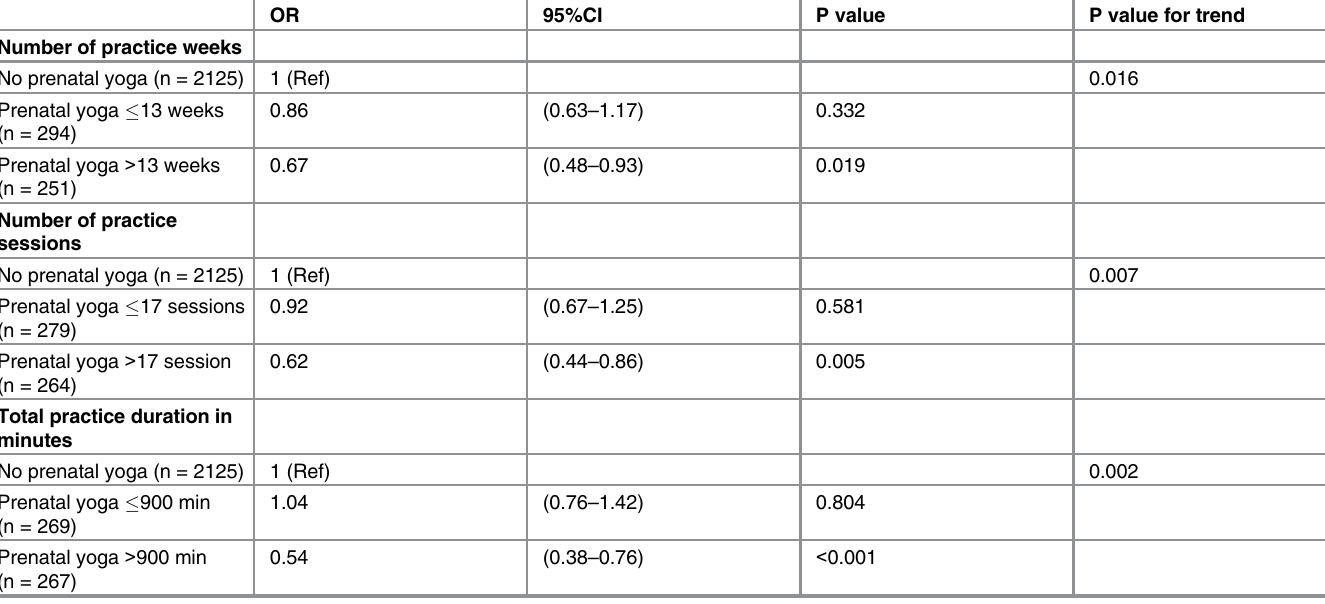
Table 3. Adjusted odd ratios for ritodrine hydrochloride use stratified by the number of yoga practice weeks, number of practice sessions, and total practice duration in minutes. OR 95%CI P value P value for